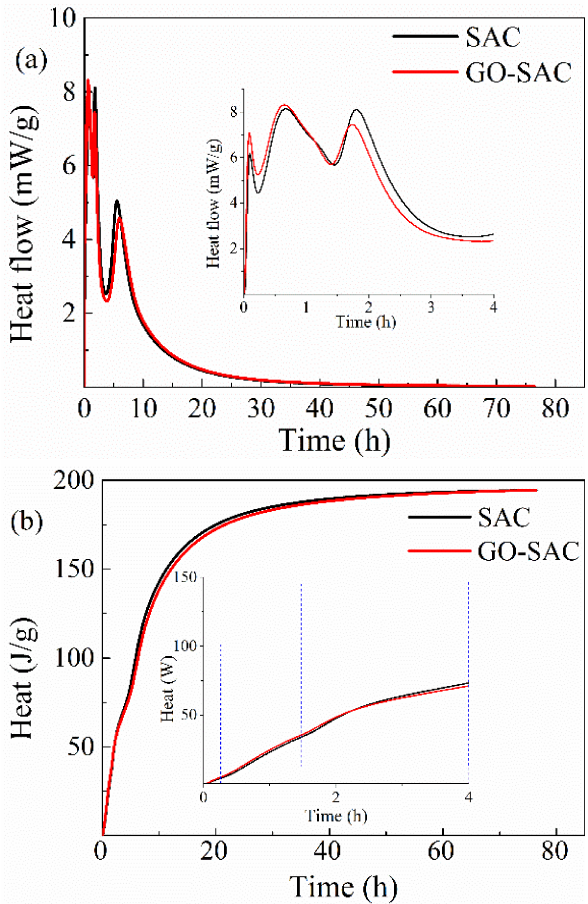
Figure 6: Hydration heat analysis of SAC and GO-SAC: (a) heat flow curves; (b) cumulative heat